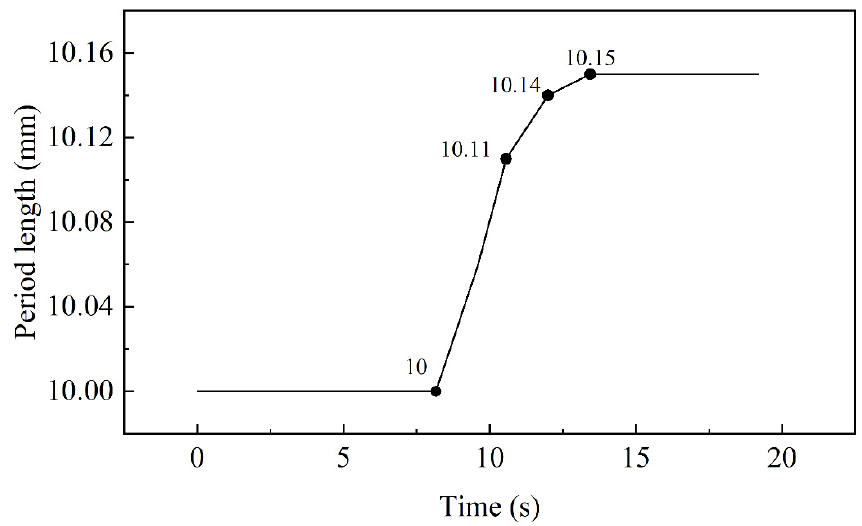
Figure 7. The period length-straightening time profiles of interface.